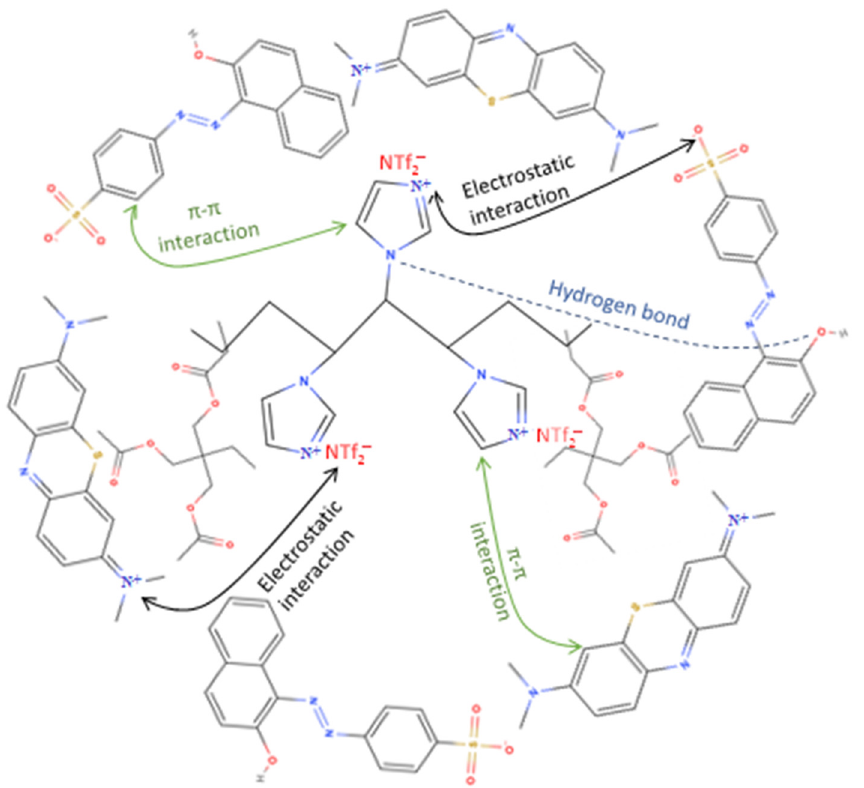
Figure 11. Schematic representation for the possible adsorption mechanism involved in this study.